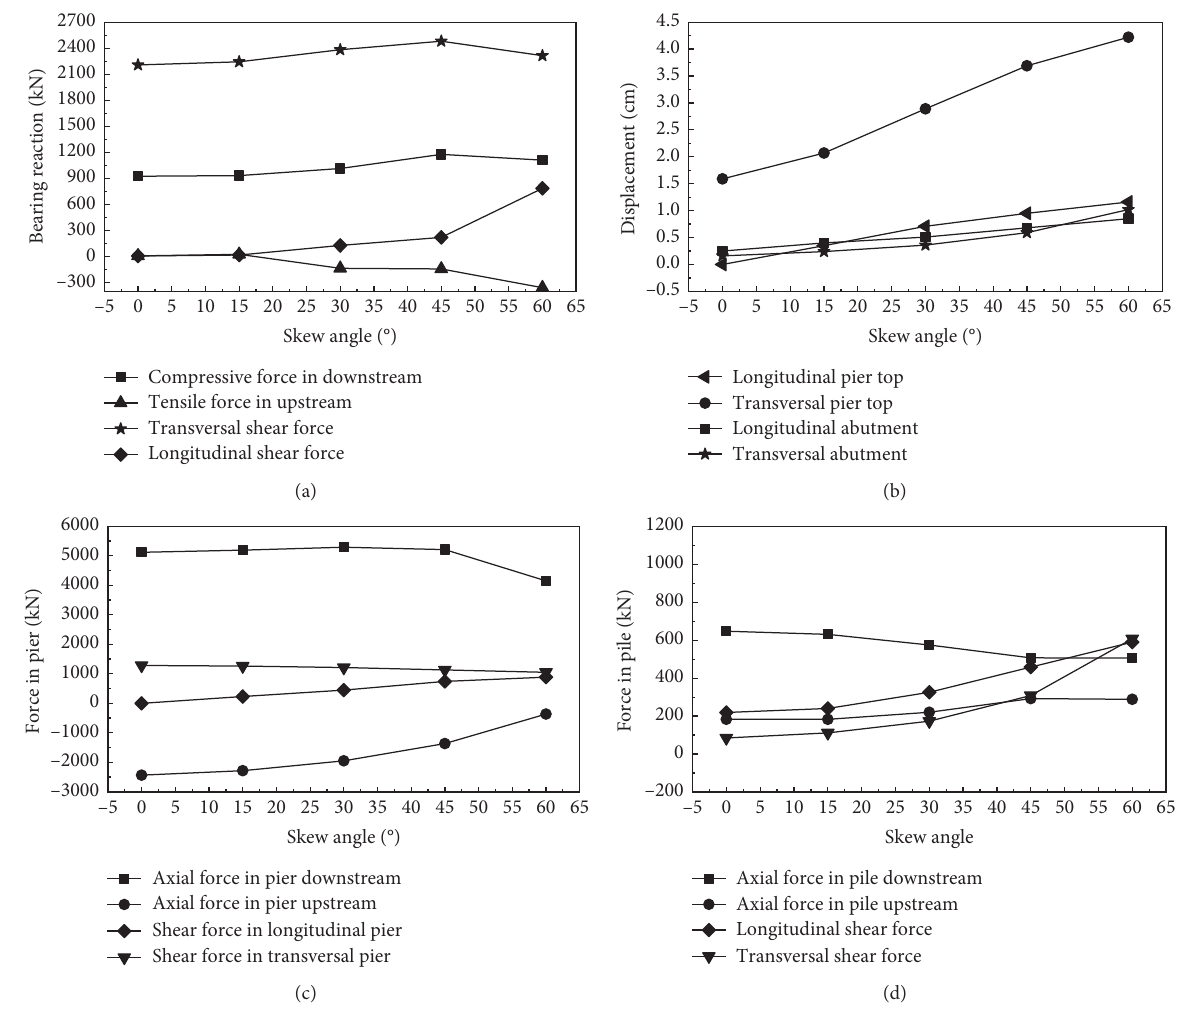
Figure 20: Variation of inner forces and deflections with skew angles. (a) Vertical force of bearings. (b) Displacement. (c) Internal force in the piers. (d) Internal force in